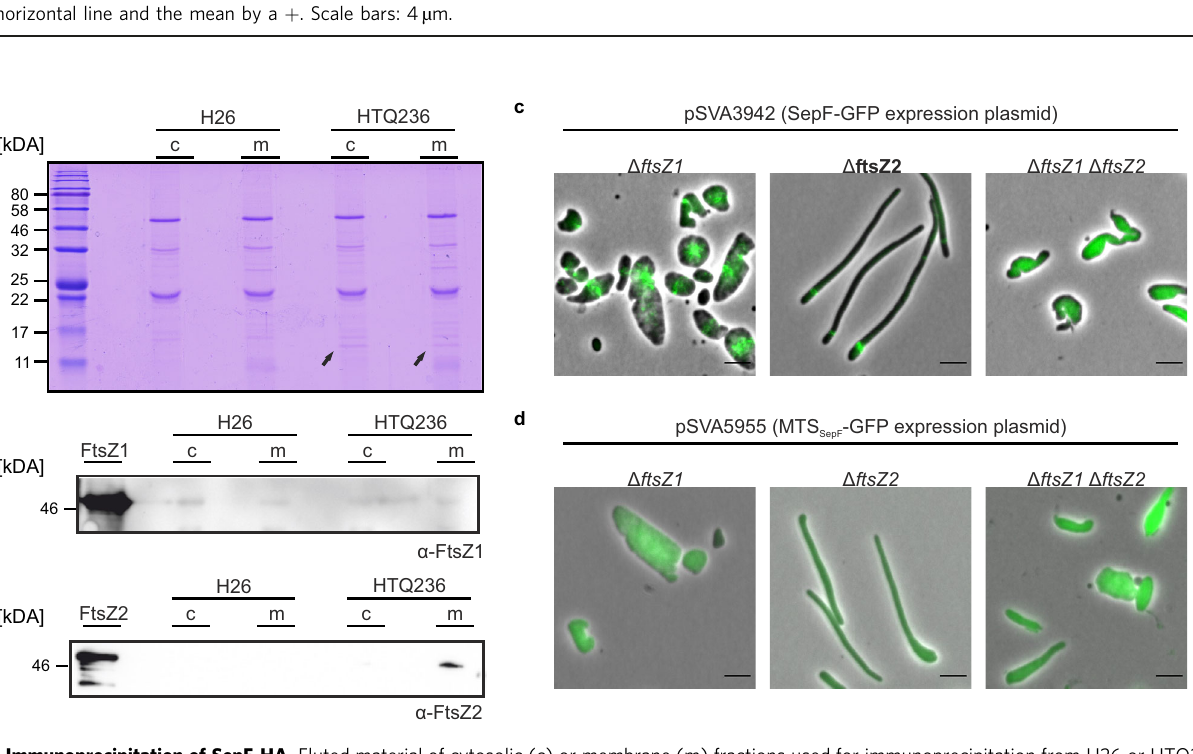
Fig. 8 Immunoprecipitation of SepF-HA. Eluted material of cytosolic (c) or membrane (m) fractions used for immunoprecipitation from H26 or HTQ236 ( sepF::sepF-ha ) were loaded on 15% SDS-gels a and analyzed via Western blots using antibodies either against FtsZ1 or FtsZ2 b . As control puri fi ed FtsZ1 or FtsZ2 were loaded. The HA-tagged SepF was visible on the Coomassie-stained gels in all pulldown fractions of strain HTQ236 (indicated by the black arrows). Experiments were repeated three times. c Fluorescence microscopy of SepF-GFP in ftsZ1 , ftsZ2, and ftsZ1/ftsZ2 deletion strains. d Fluorescence microscopy of MTS SepF -GFP in ftsZ1 , ftsZ2, and ftsZ1/ftsZ2 deletion strains. The experiments were repeated three times independently with similar results. Scale bars: 4 µ m.